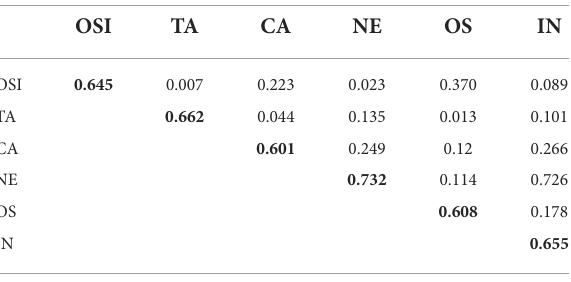
TABLE 6 Average variance extracted and squared correlations of constructs. OSI TA CA NE OS IN OSI